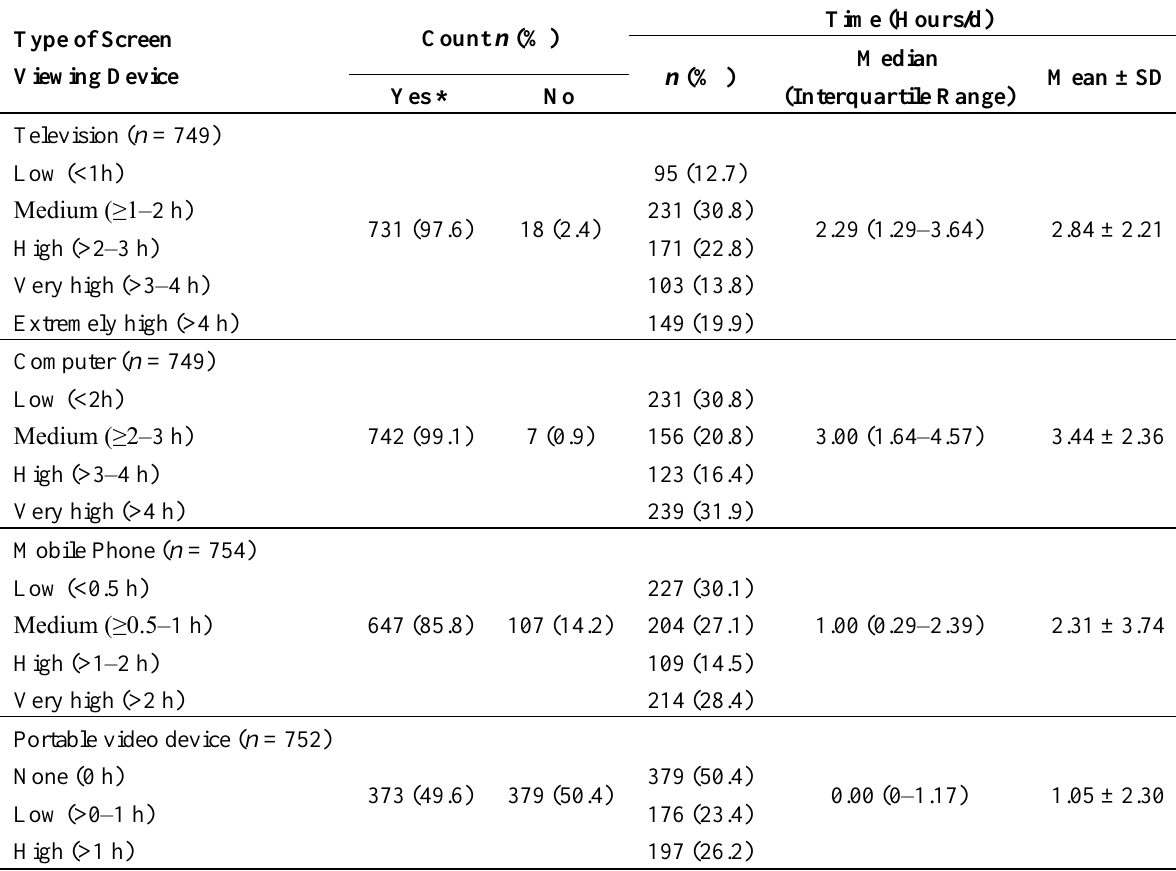
Table 3. Prevalence and Duration of Screen Use by the